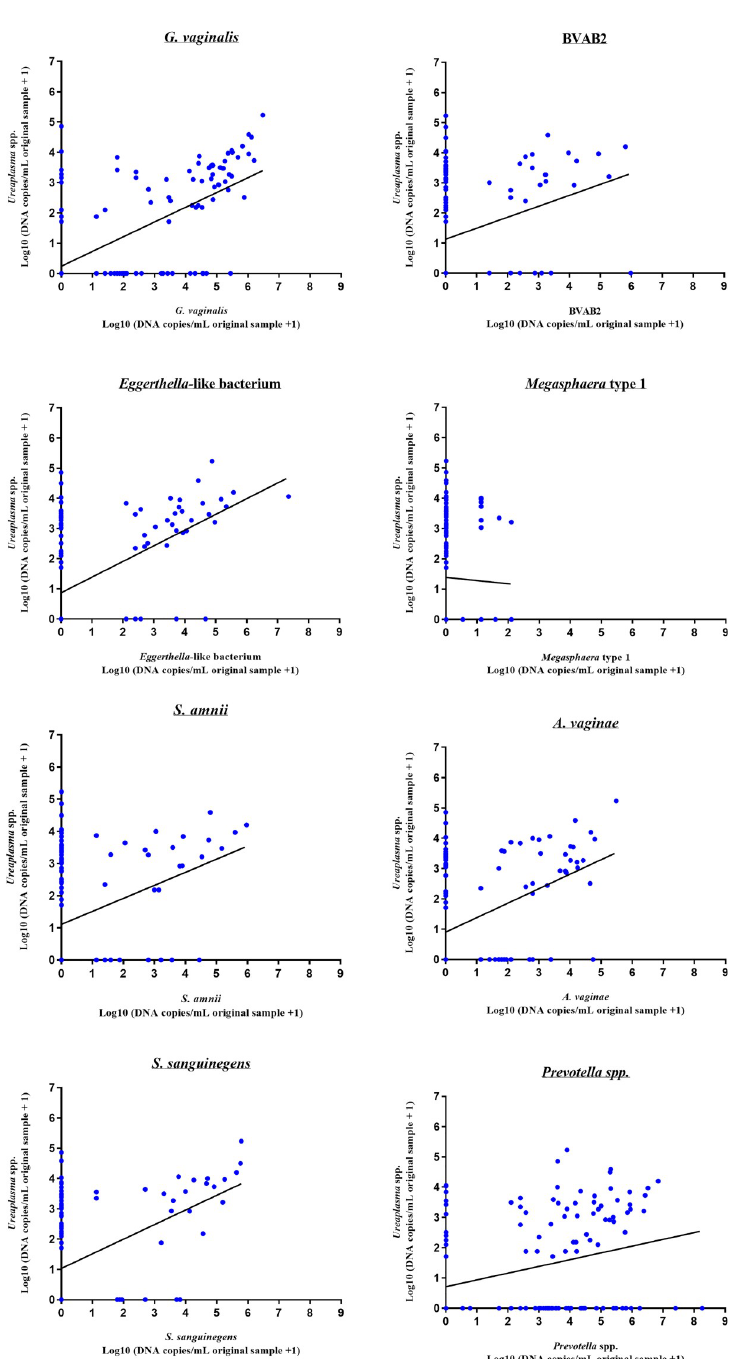
Fig 2. Comparison of the eight BV associated bacteria and total ureaplasma load ( U . urealyticum and U . parvum ) in all 141 samples. Regression lines are